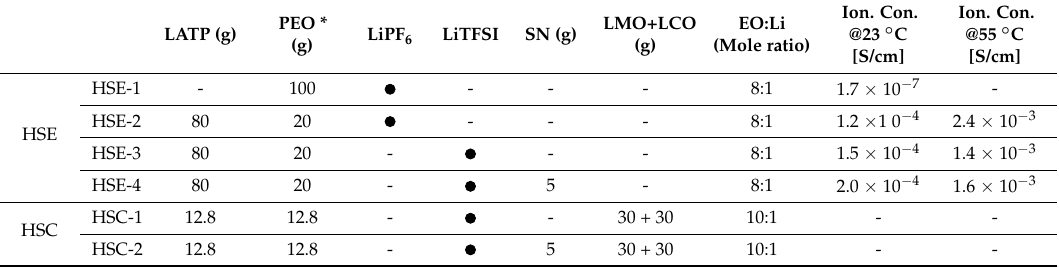
Table 1. Designed hybrid solid electrolyte (HSE) and hybrid solid cathode (HSC) in this